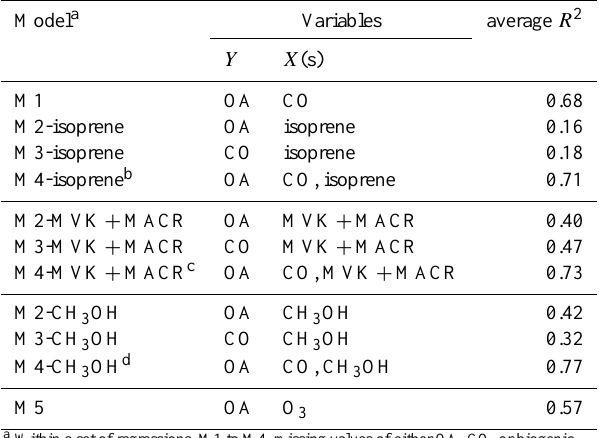
a Within a set of regressions, M1 to M4, missing values of either OA, CO, or biogenic tracer were treated by removing all three data (listwise deletion). b Average of standardized regression slopes for model M4-isoprene S , β 4CO = 0 . 80 , β 4ISOPRENE =− 0 . 01 . c Average of standardized regression slopes for